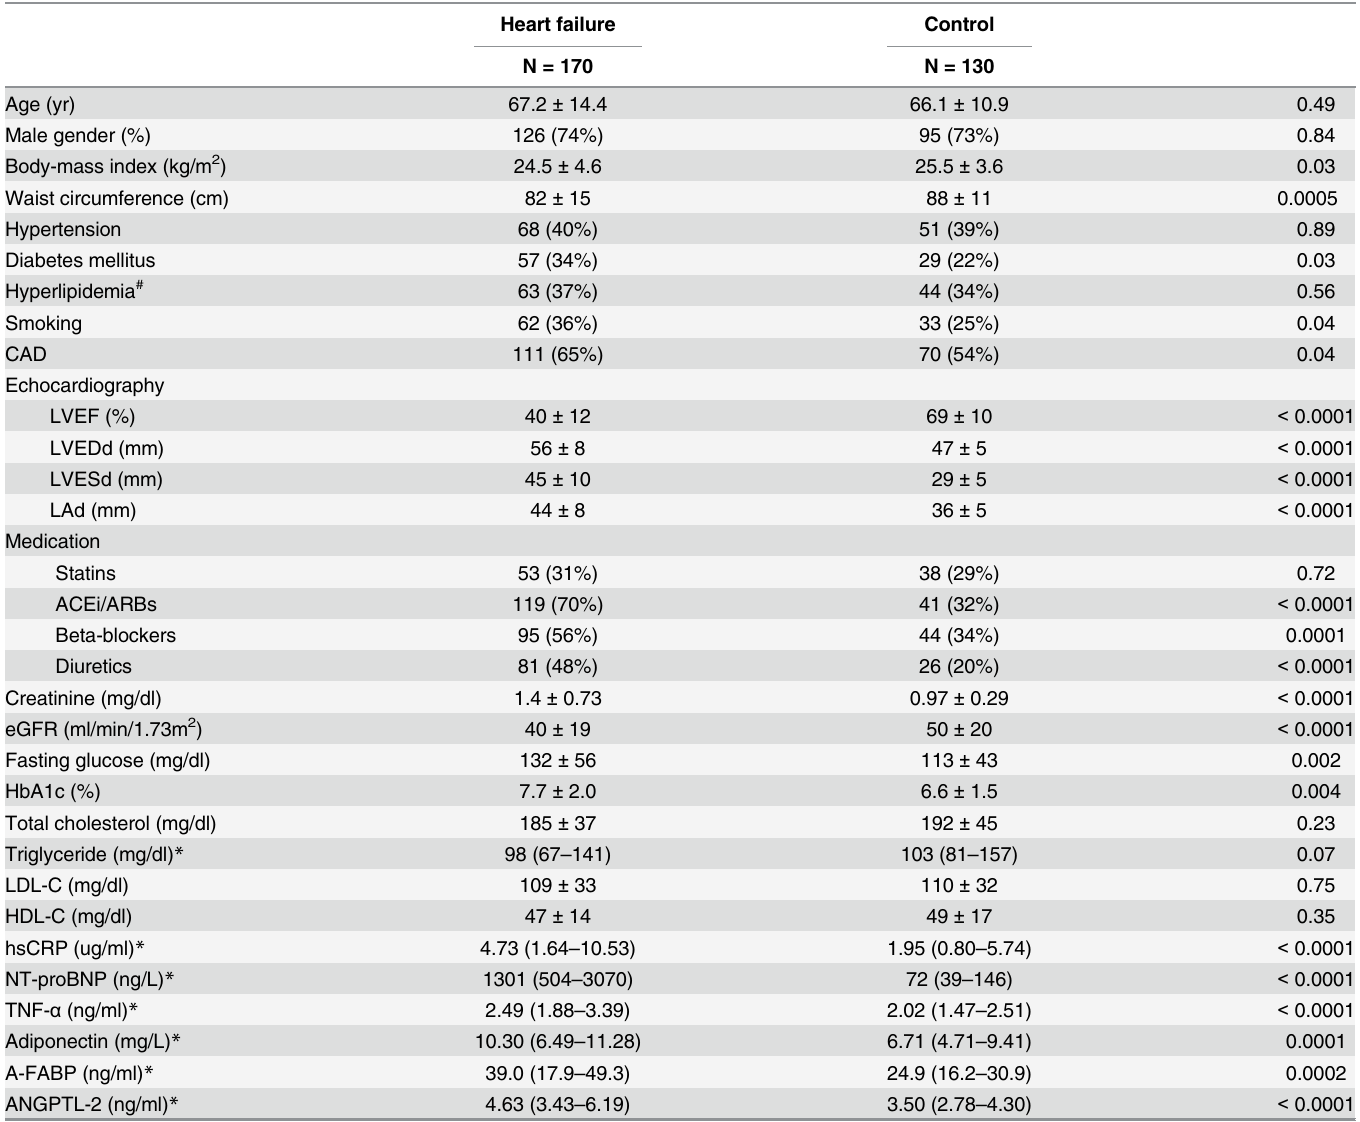
Table 1. Characteristics of patients with heart failure and